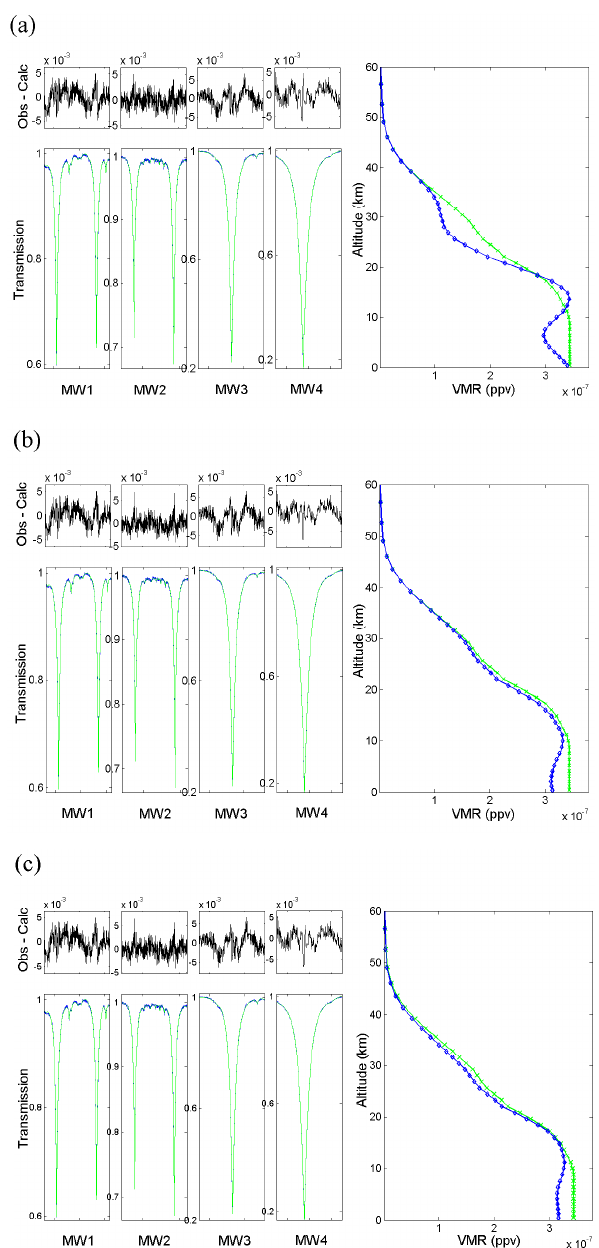
Figure 5. Multiple micro-window (MW1: 2481.30 – 2482.60, MW2: 2526.40 – 2528.20, MW3: 2537.85 – 2538.80, and MW4: 2540.10 – 2540.70 cm -1 ) fit of N 2 O plus interfering species from a single spectrum on 8 October 2007 at St.-Denis using the (a) OEM, (b) IOA and (c) TR. Measured (blue) and simulated (green) spectra are shown (left lower plot), together with the residuals (left upper plot), computed as measured minus simulated. The right plot shows the a priori (green crosses) and retrieved (blue diamonds)